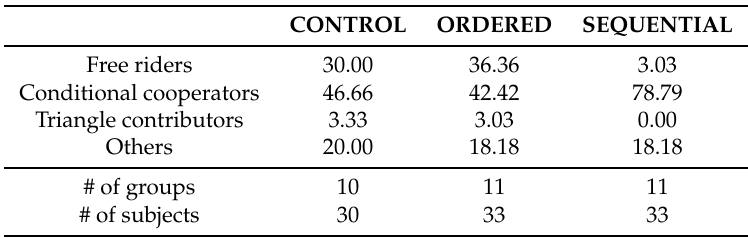
Table 1. Type classification by treatment using FGF rule. Entries are percentages of each type for each